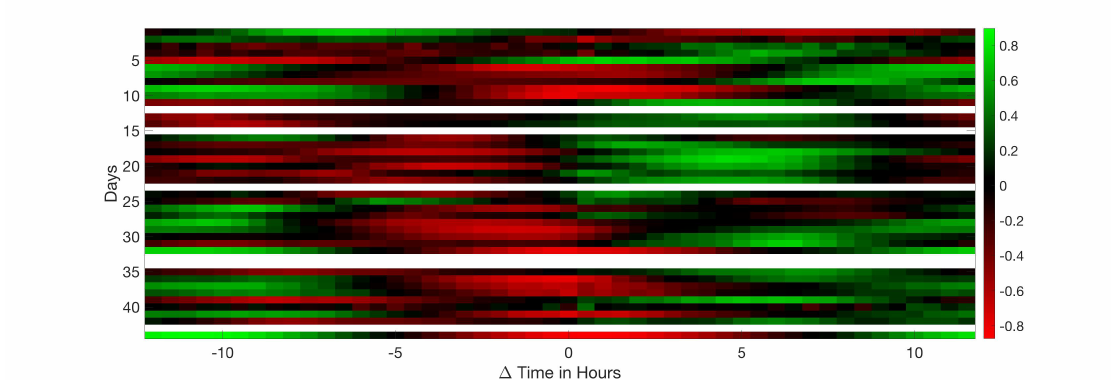
Figure 19. Results of the circular correlation temperature—humidity. Horizontal axis corresponds to the ∆ Time measured in hours, evaluating the delay between temperature and humidity. Vertical axis stands for the days of the